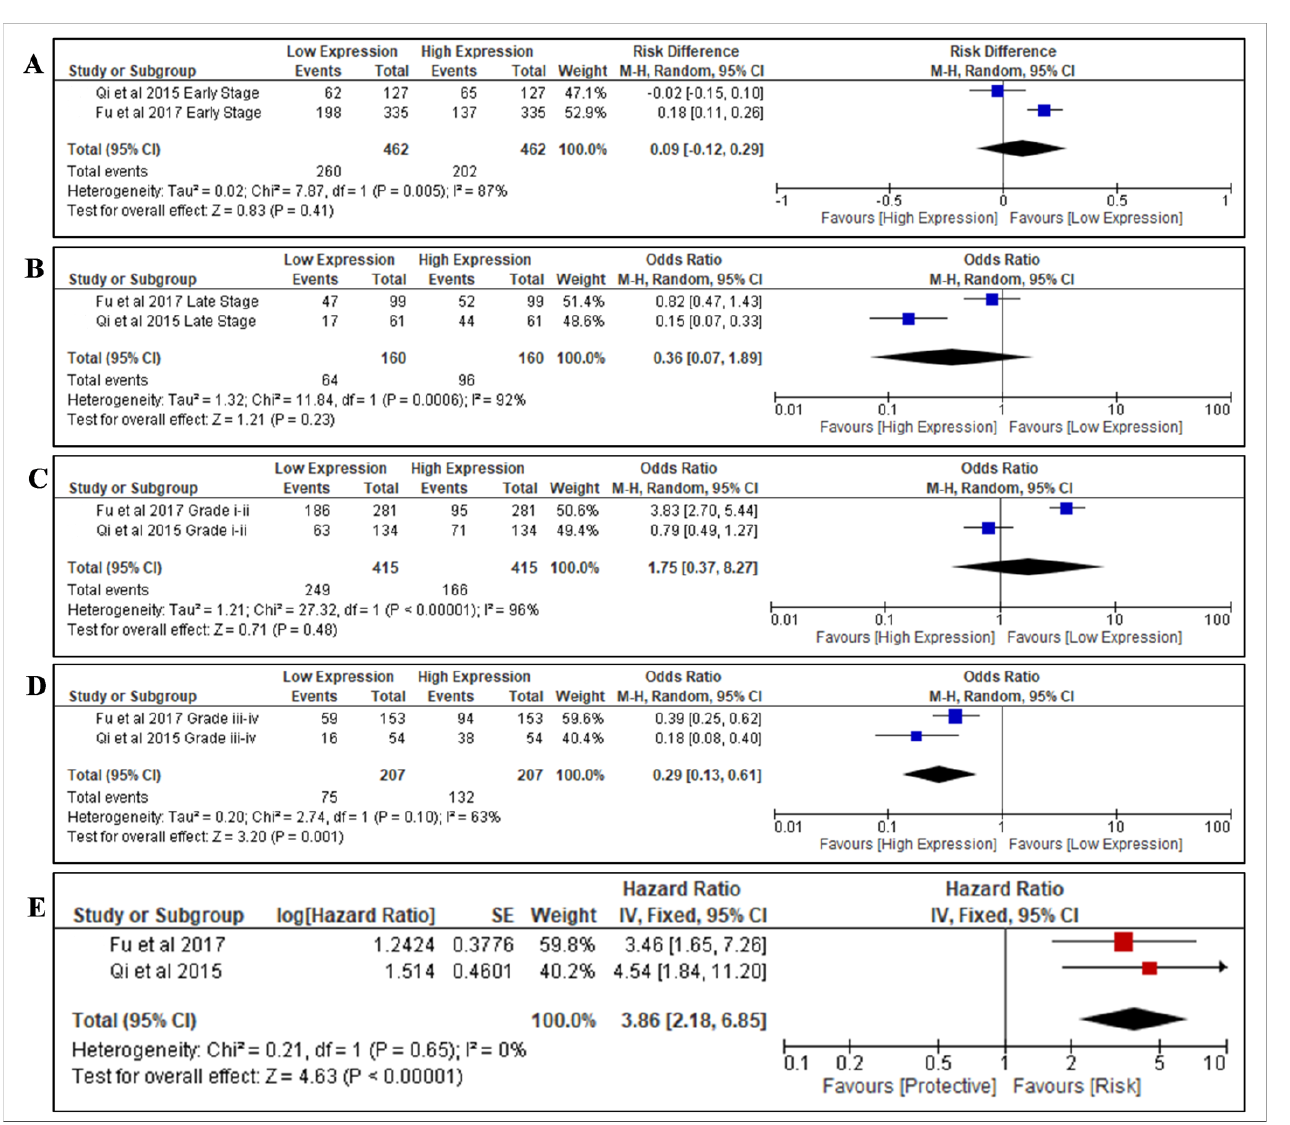
Figure 2. Forest plots of included studies on prognostic value of nesfatin-1. ( A ) Prognostic value of nesfatin-1 in RCC localised disease (Early Stage). ( B ) Prognostic value of nesfatin-1 in RCC advanced disease (Late Stage). ( C ) Prognostic value of nesfatin-1 in localised RCC disease (Low Grade). ( D ) Prognostic value of nesfatin-1 in advanced RCC disease (high grade). ( E ) Expression of nesfatin-1